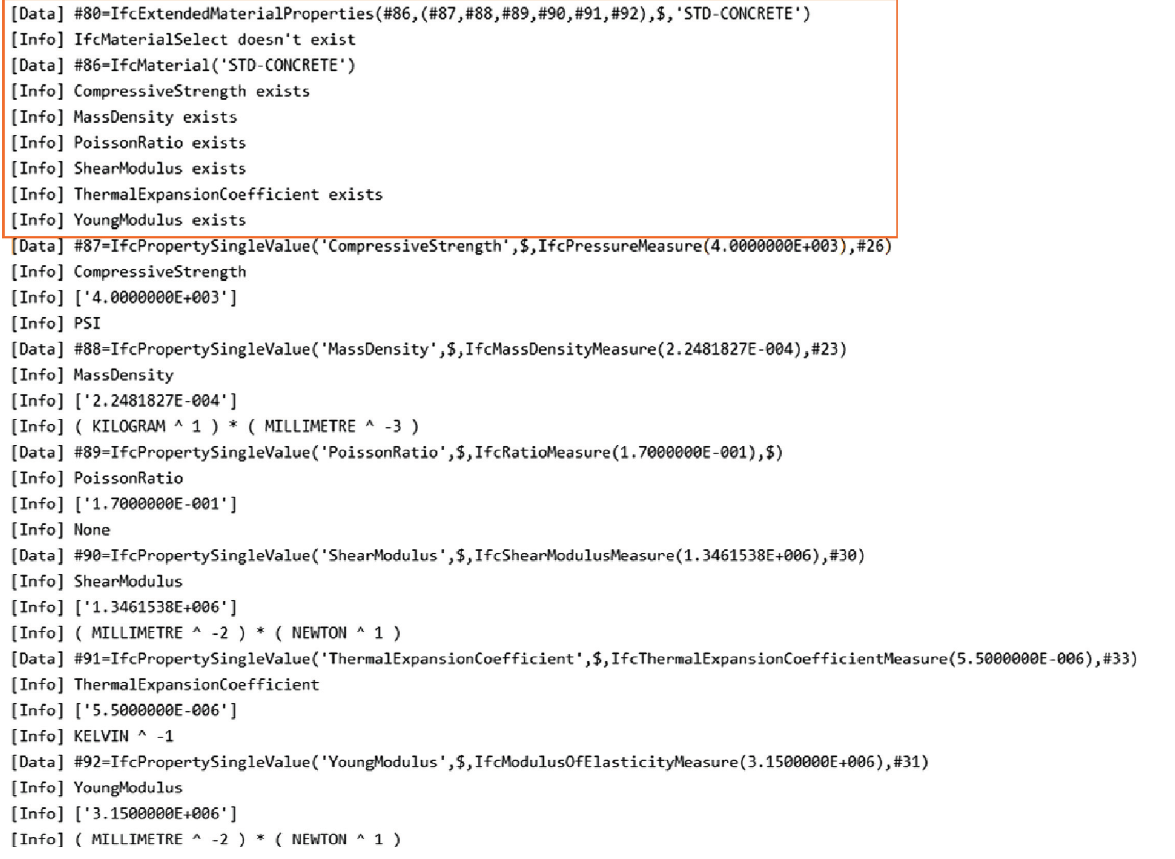
Figure 12: Report of material information checking results by customized Table 5: Performance comparison of the proposed information checking method with manual checking method.